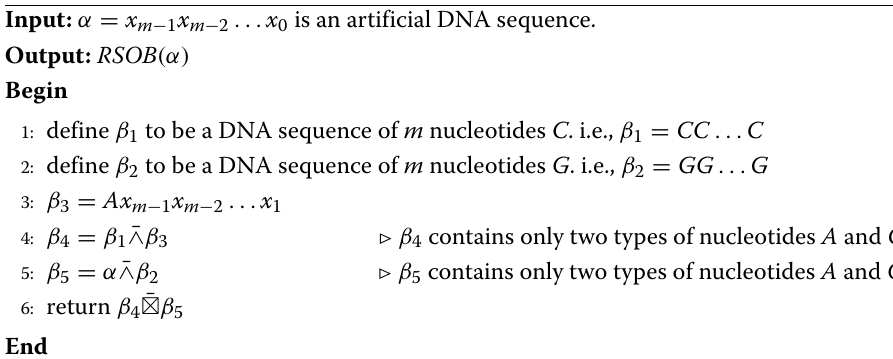
Algorithm 5 RSOB operation